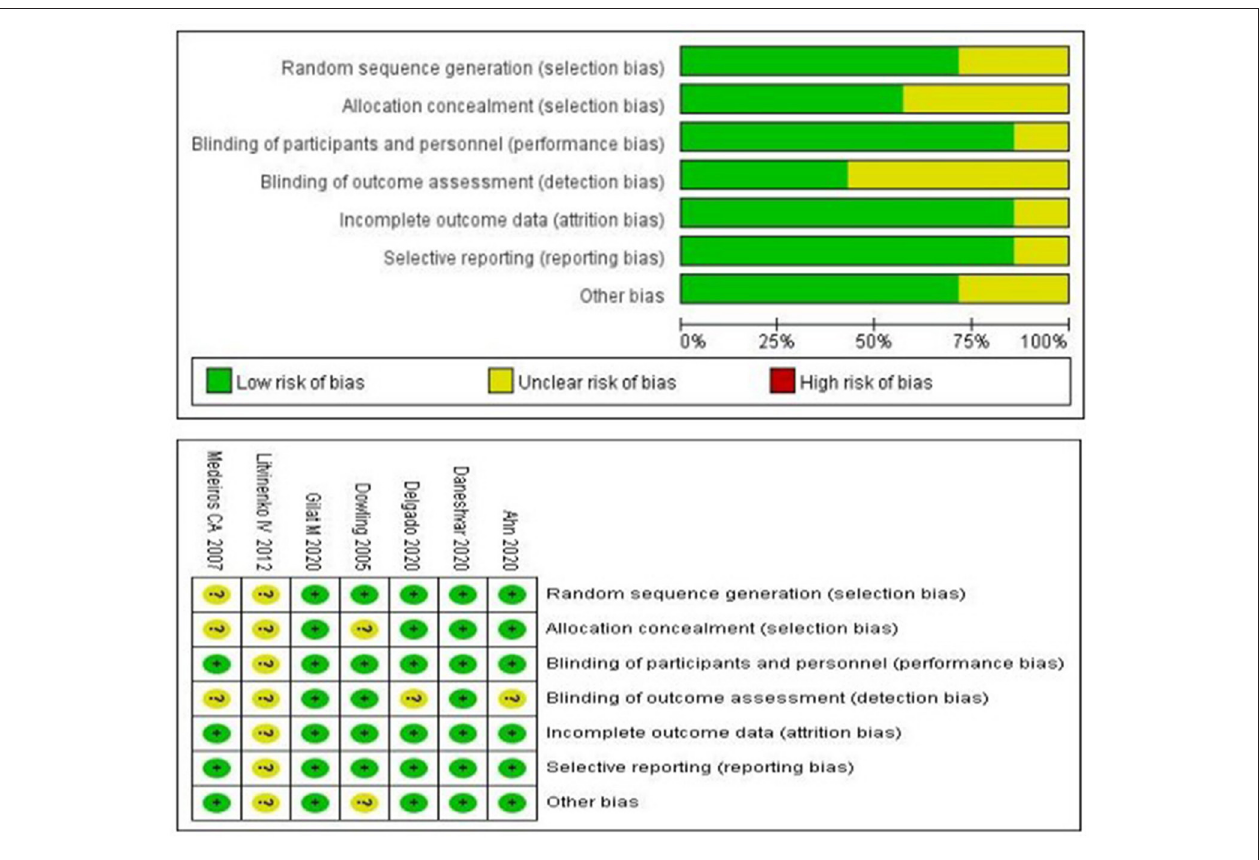
FIGURE 2 | Quality assessment of the included studies.